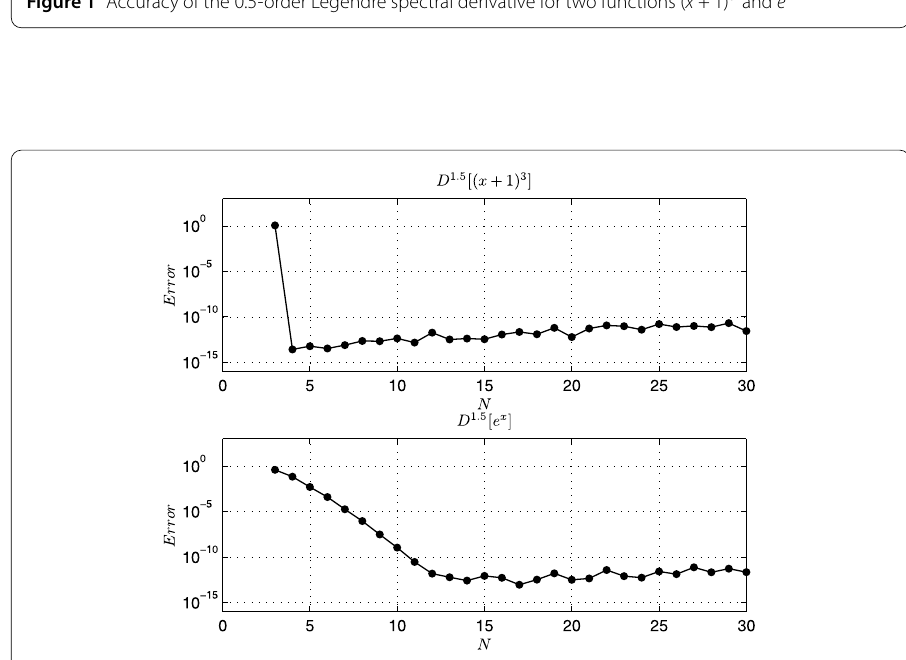
Figure 2 Accuracy of the 1.5-order Legendre spectral derivative for two functions ( x + 1) 3 and e x